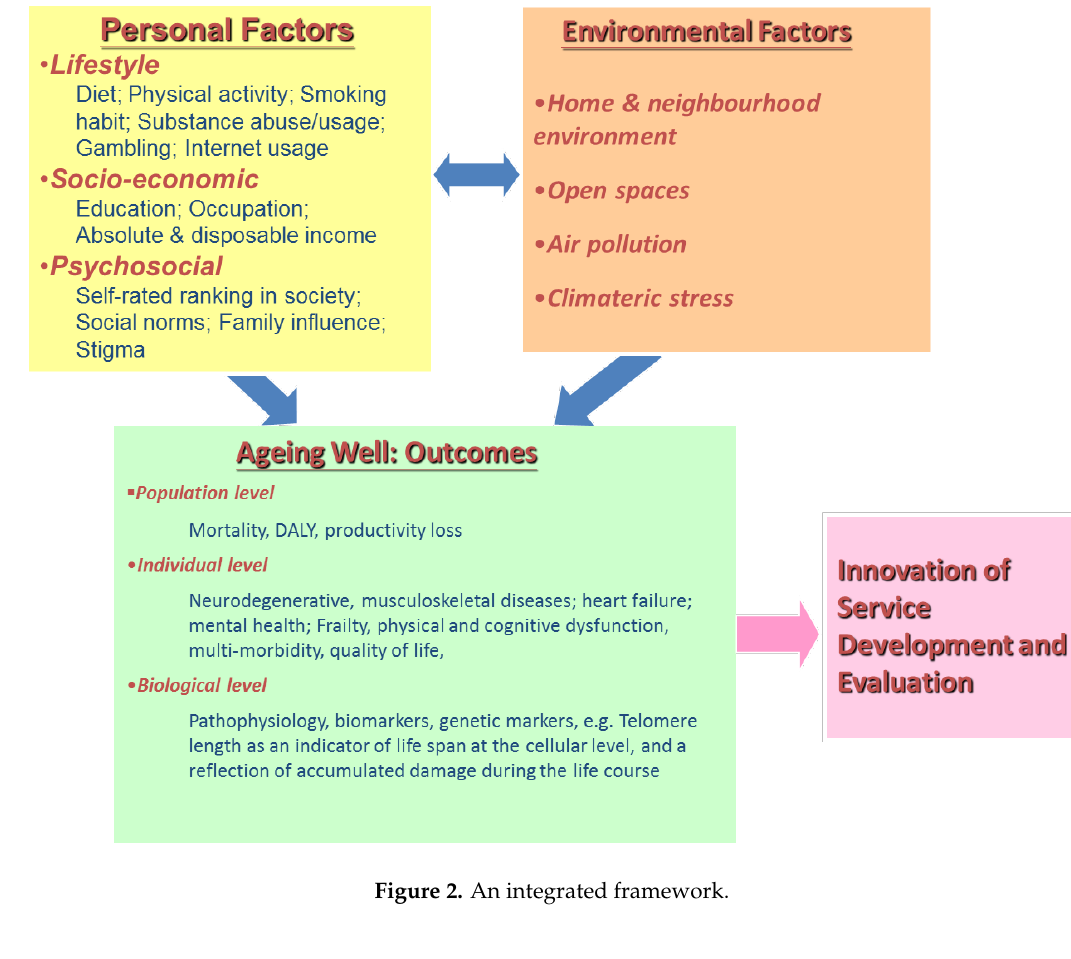
Figure 2. An integrated framework.